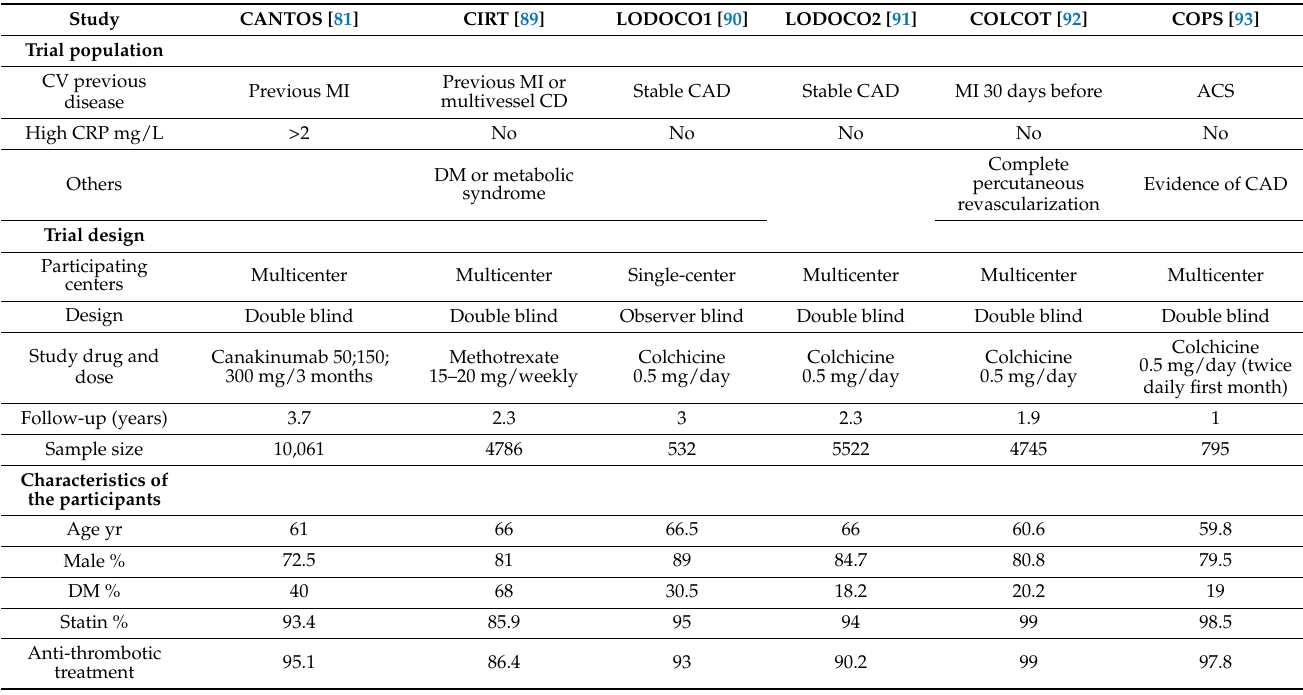
Table 1. Summary of relevant clinical trials about canakinumab, methotrexate and